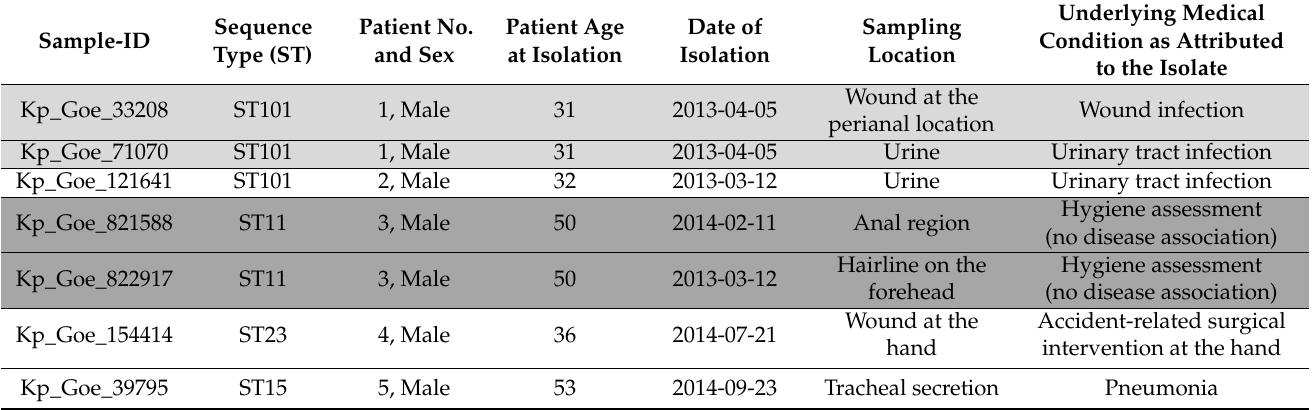
Table 1. Clinical information available for the seven assessed oxacillinase-48 (OXA-48) producing bla OXA-48 -positive Klebsiella pneumoniae isolates from five hospitalized patients in Germany from the blinded analyses. Isolates from the same patient are shaded in identical gray